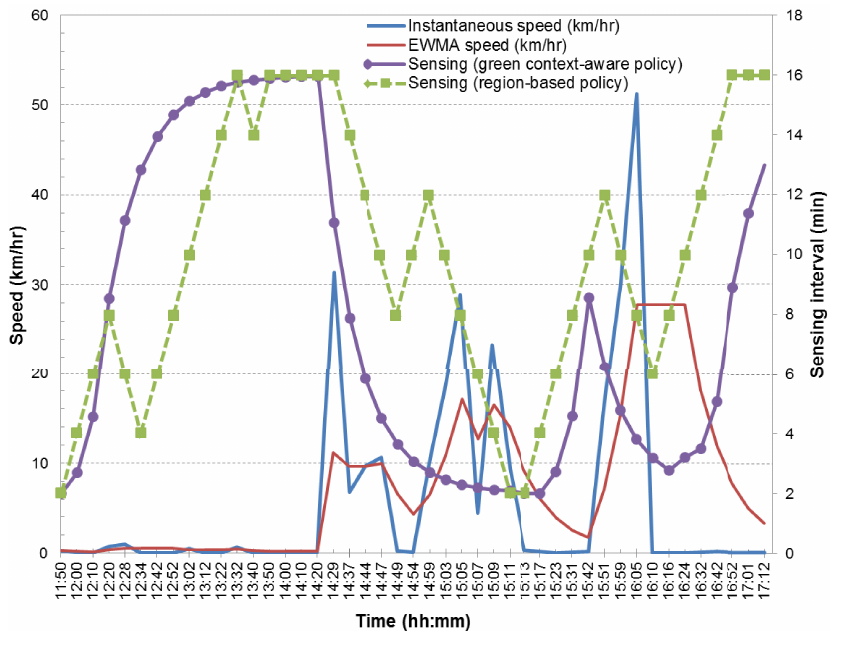
Figure 7. Behavior of adaptive sensing intervals based on observed